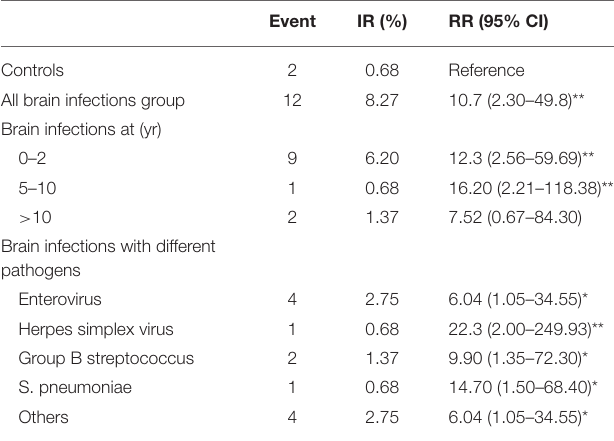
TABLE 2 | Incidence rates and relative risks of epilepsy for the controls compared with brain infections cohort. Event